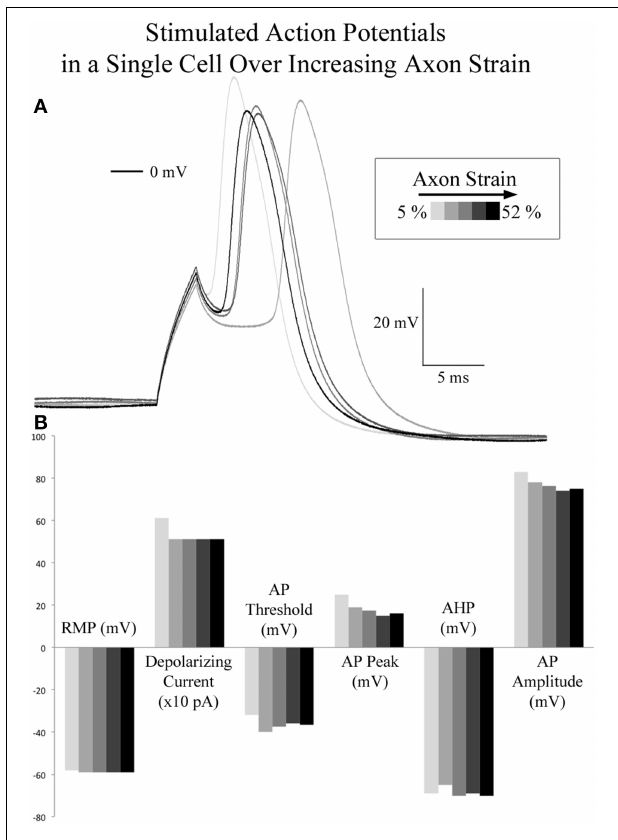
FIGURE 5 | Current stimulated action potentials during real-time axon stretch. (A) Overlaid current stimulated action potential traces corresponding to 5, 10, 21, 37, and 52% axon strain in a single cell. (B) Action potential attributes did not correlate with axon strain. At 500 pA depolarizing current, peak voltage decreased by 3mV as strain was increased